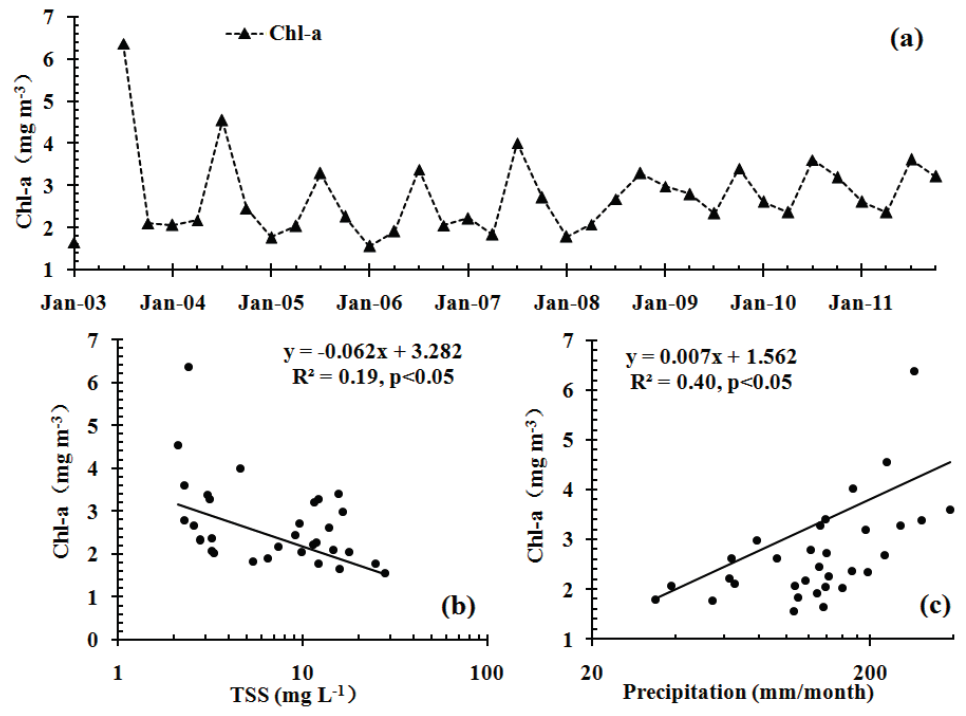
Figure 10. ( a ) Seasonal mean Chl-a of Poyang Lake from 2003 to 2011. Some of the missing data were due to a lack of cloud-free MERIS images in that season. ( b ) Correlation between seasonal Chl-a and TSS. ( c ) Correlation between seasonal Chl-a (with a temporal lag of one season) and